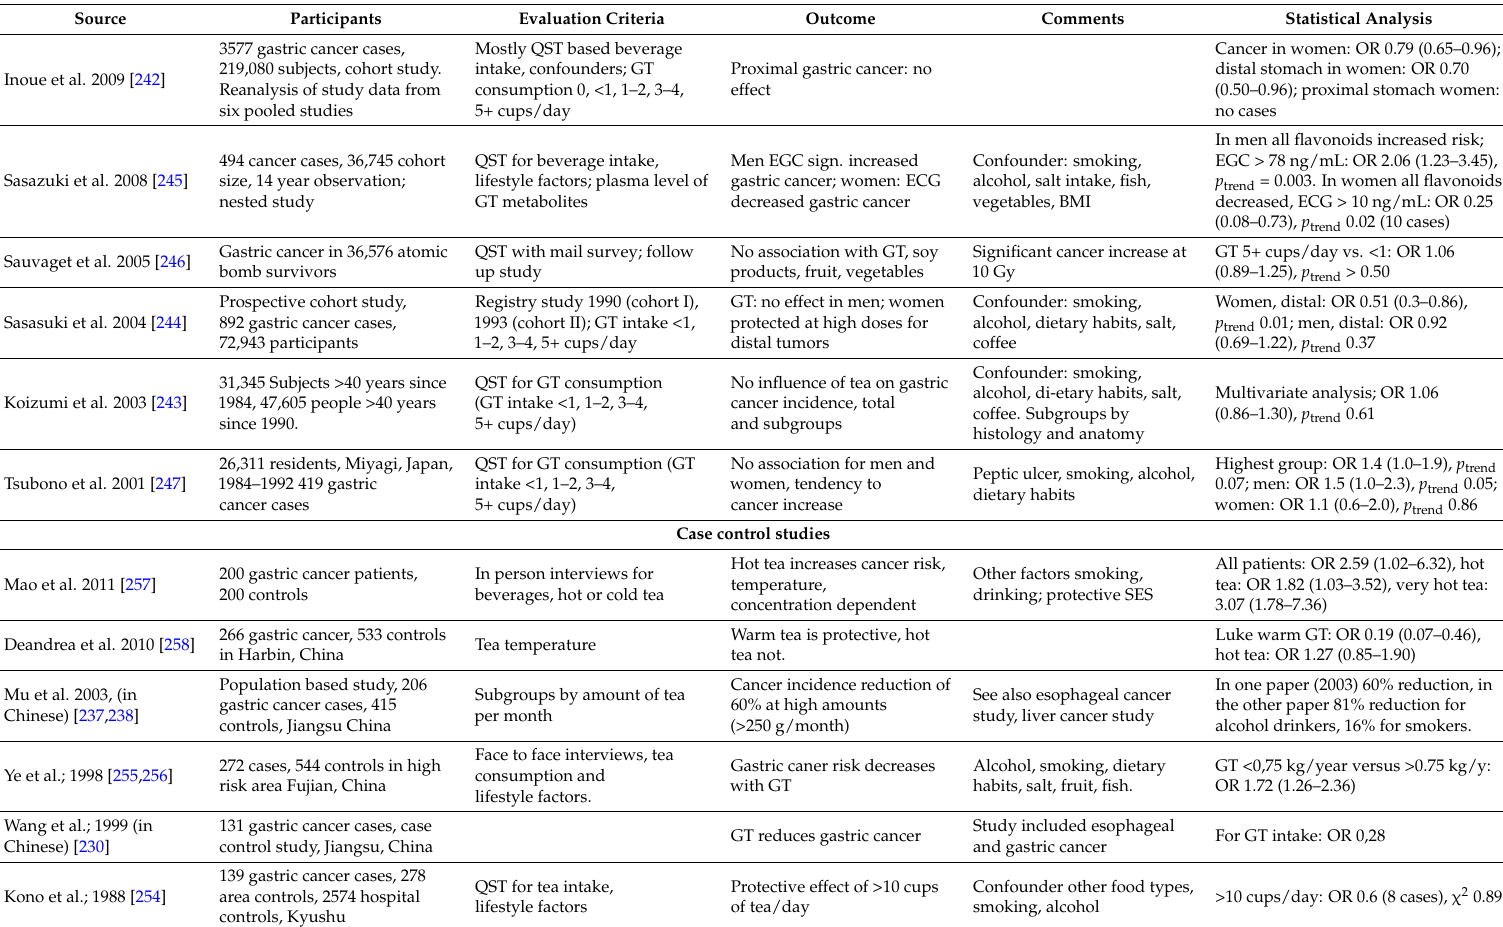
Table 9. Correlation of GTE consumption and chemoprevention of gastric